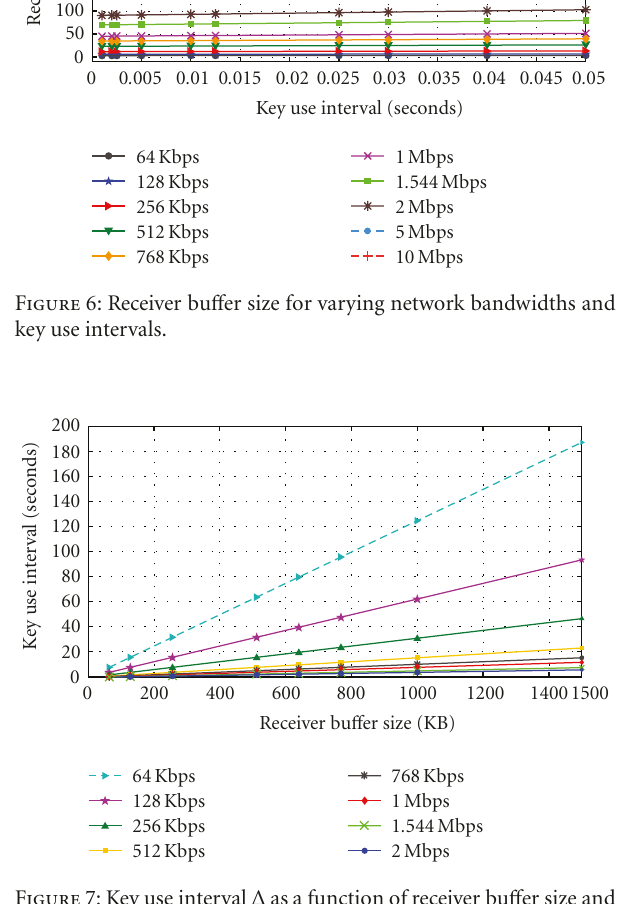
Figure 7: Key use interval Δ as a function of receiver bu ff er size and network